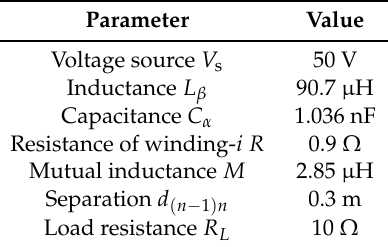
Table 1. Simulation Parameters.